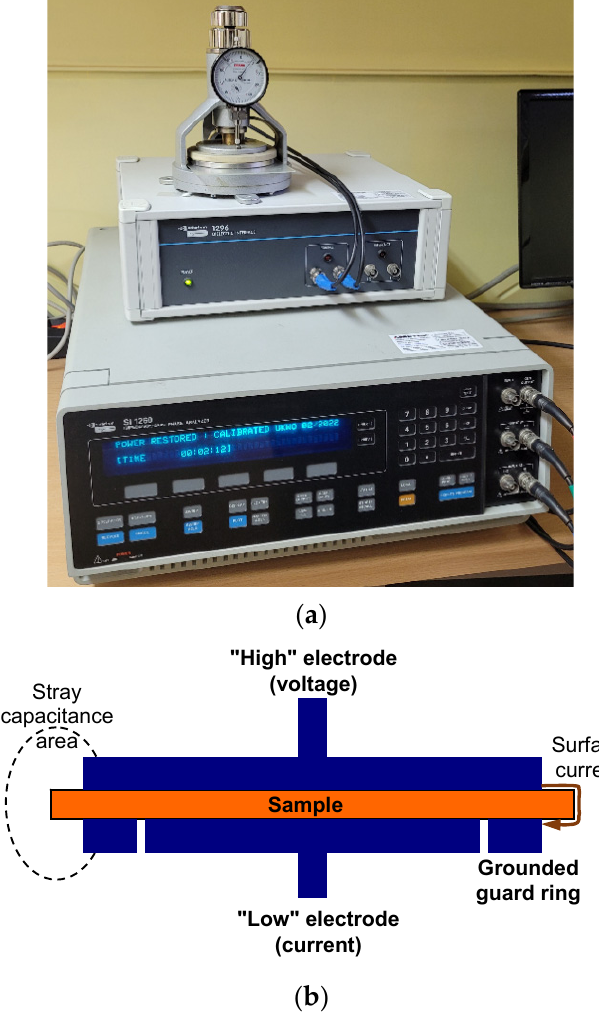
Figure 1. Broadband dielectric characteristics measurement setup: ( a ) test stand with Solartron 1260A Frequency Response Analyzer [53], Solartron 1296A Dielectric Interface [54] and solid dielectric sample holder, adjustable three-electrode capacitor; ( b ) configuration of disk electrodes with guard-ring in the sample holder, as recommended in [55,56] for solid dielectric samples.